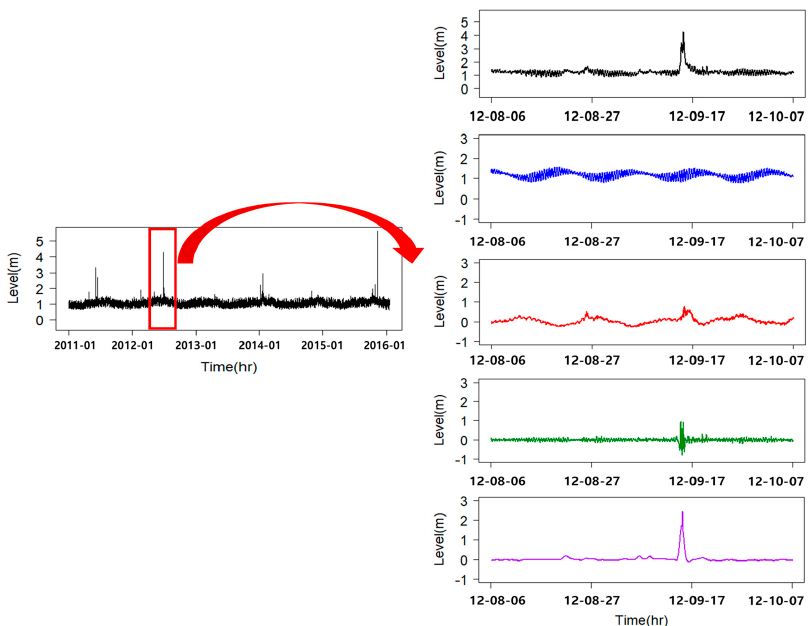
Figure 10. Validation of time series decomposition (Typhoon ‘Sanba’).